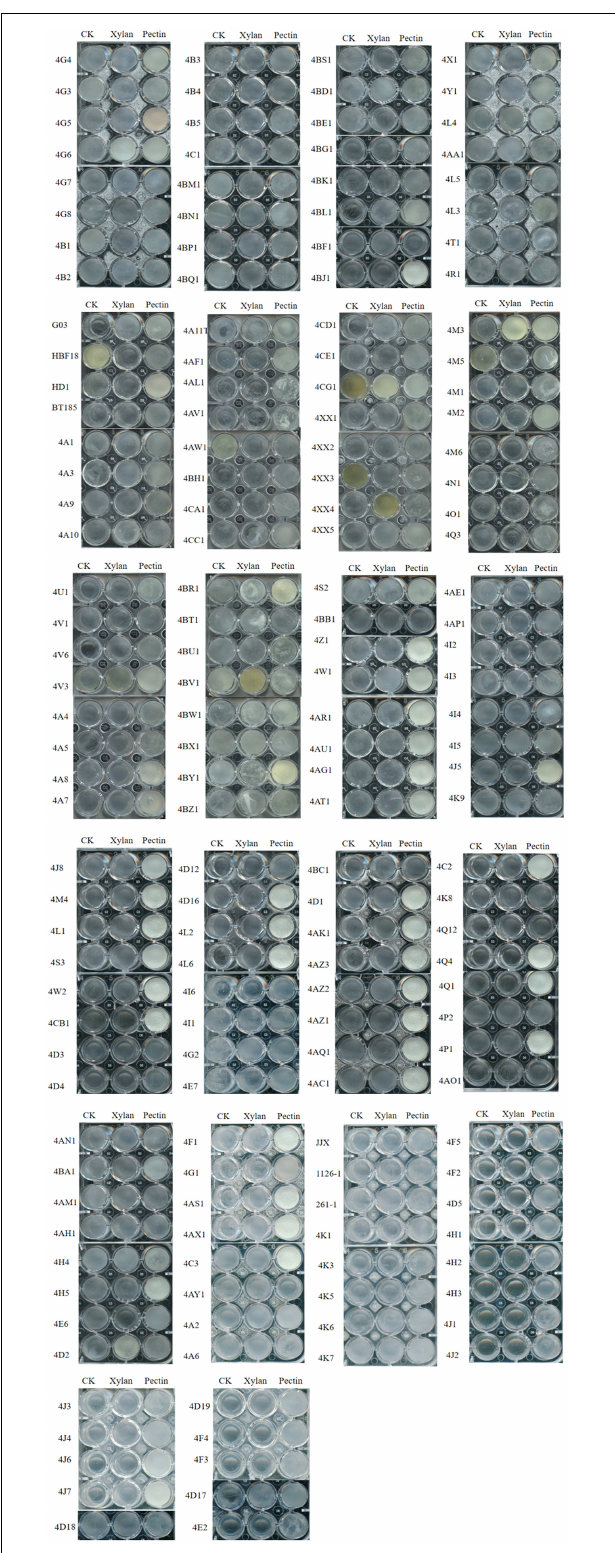
FIGURE 1 | Effects of plant polysaccharides xylan and pectin on the biofilms formed by 170 Bt strains.